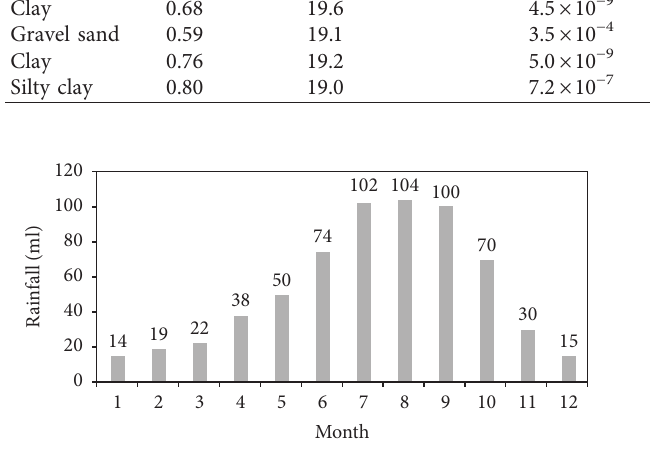
Figure 4: Monthly distribution of annual rainfall in 2017.